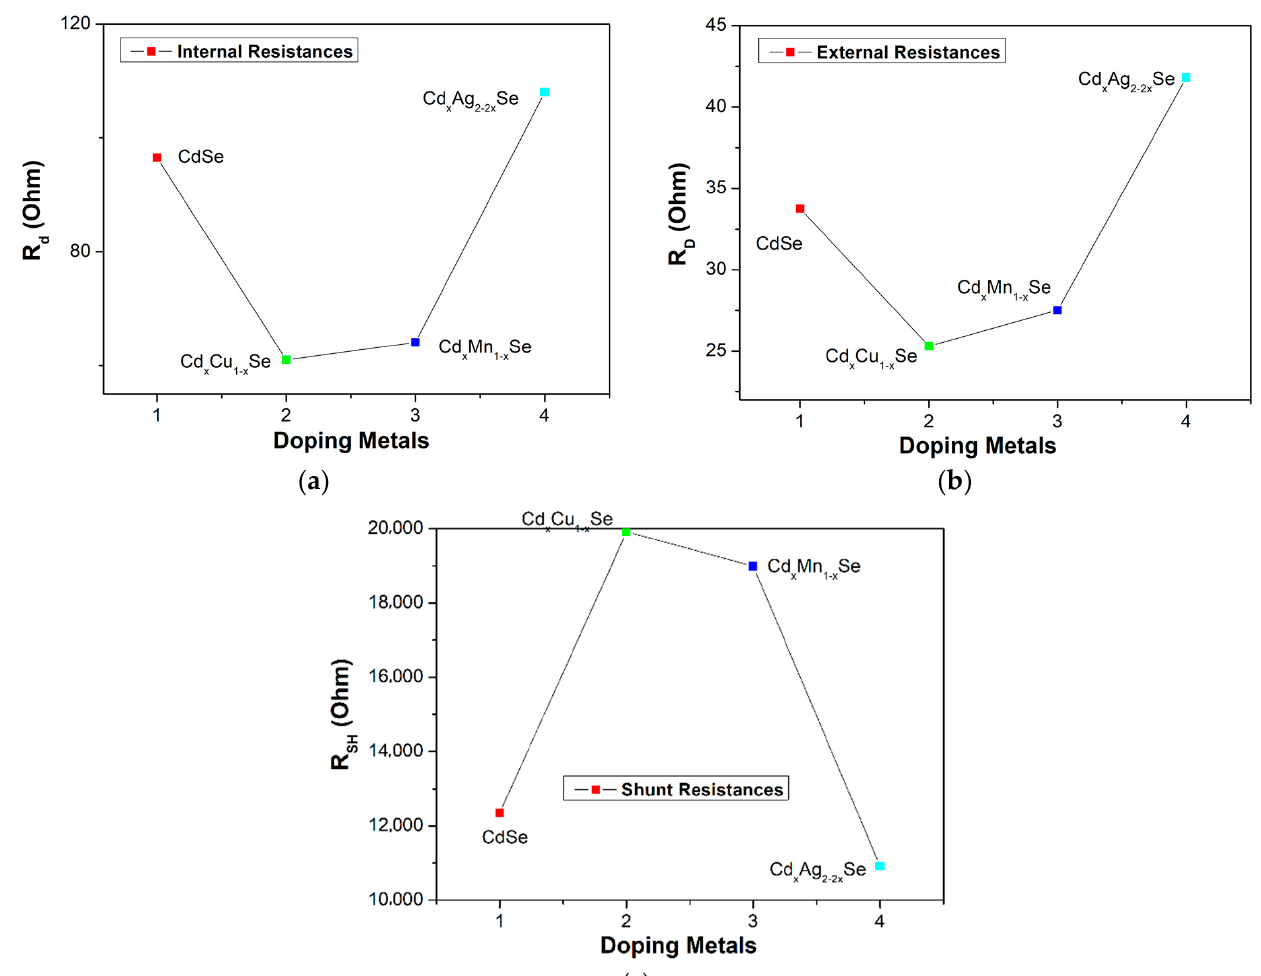
Figure 8. Dependence of ( a ) the external resistance, ( b ) internal resistance, and ( c ) shunt resistance on metal addition in films.